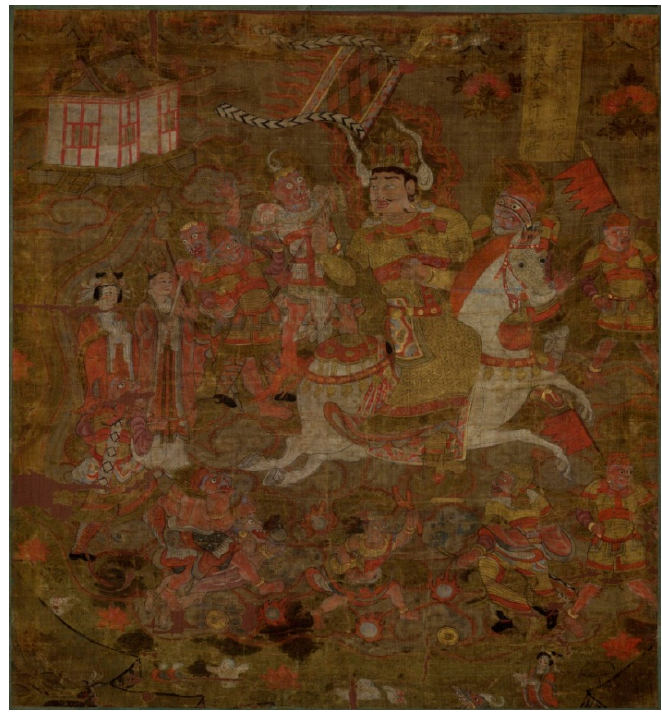
Figure 15. Vai ś rava ṇ a . Dunhuang, mid-10th century . Ink and colors on silk, 61.8 × 57.4 cm. The British Figure 15. Vai´sravan. a . Dunhuang, mid-10th century. Ink and colors on silk, 61.8 × 57.4 cm. The British Museum (1919,0101,0.26) © The Trustees of the British Museum. Museum (1919,0101,0.26) © The Trustees of the British